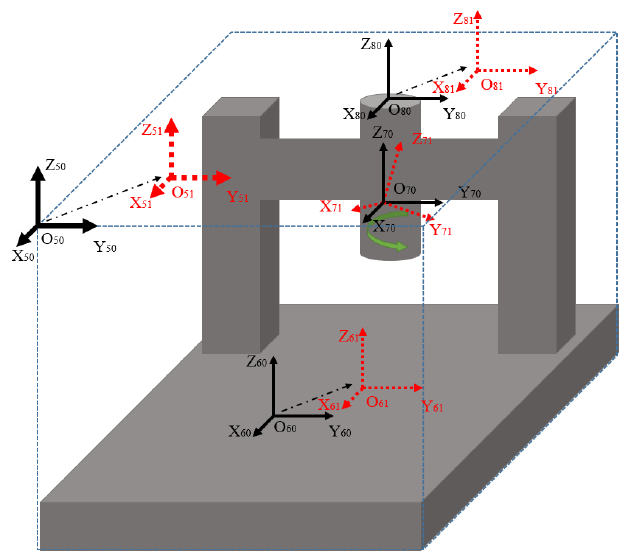
Figure 3. Coordinate System of Three-coordinate Measuring Instrument.